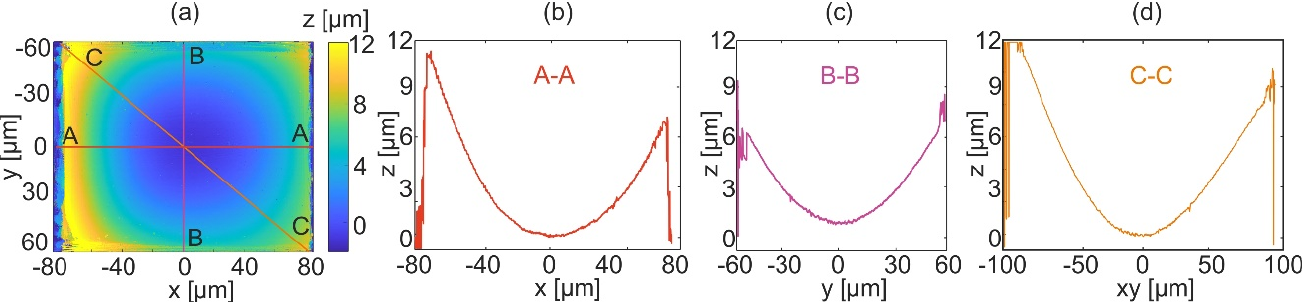
Figure 12. Results of the topography reconstruction of the mold with geometrically frequency spaced strategy: ( a ) 2D map, ( b ) horizontal cross-section (A-A), ( c ) vertical cross-section (B-B), and ( d ) diagonal cross-section (C-C).